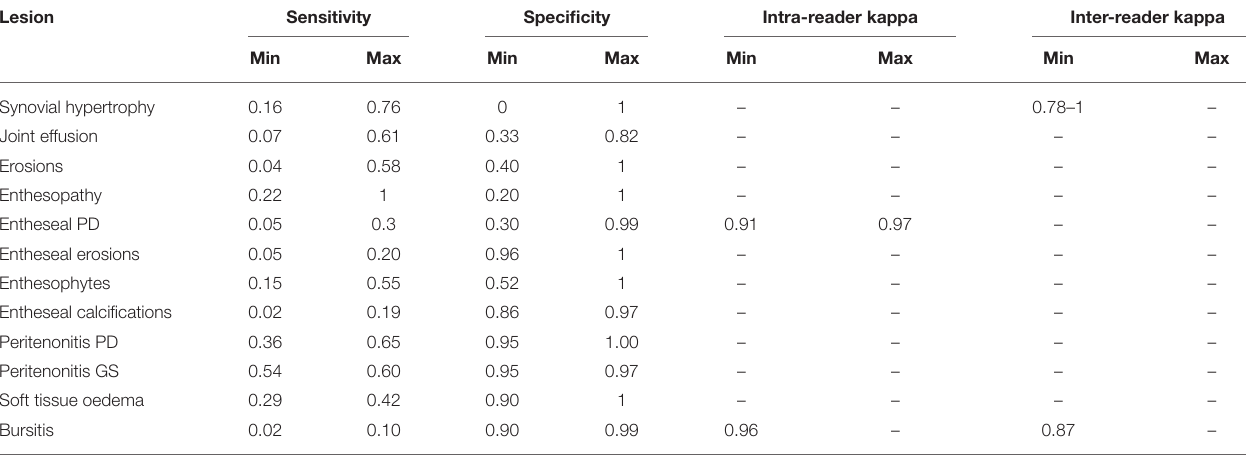
TABLE 5 | Performance of ultrasound lesions to detect PsA and reproducibility. Lesion Sensitivity